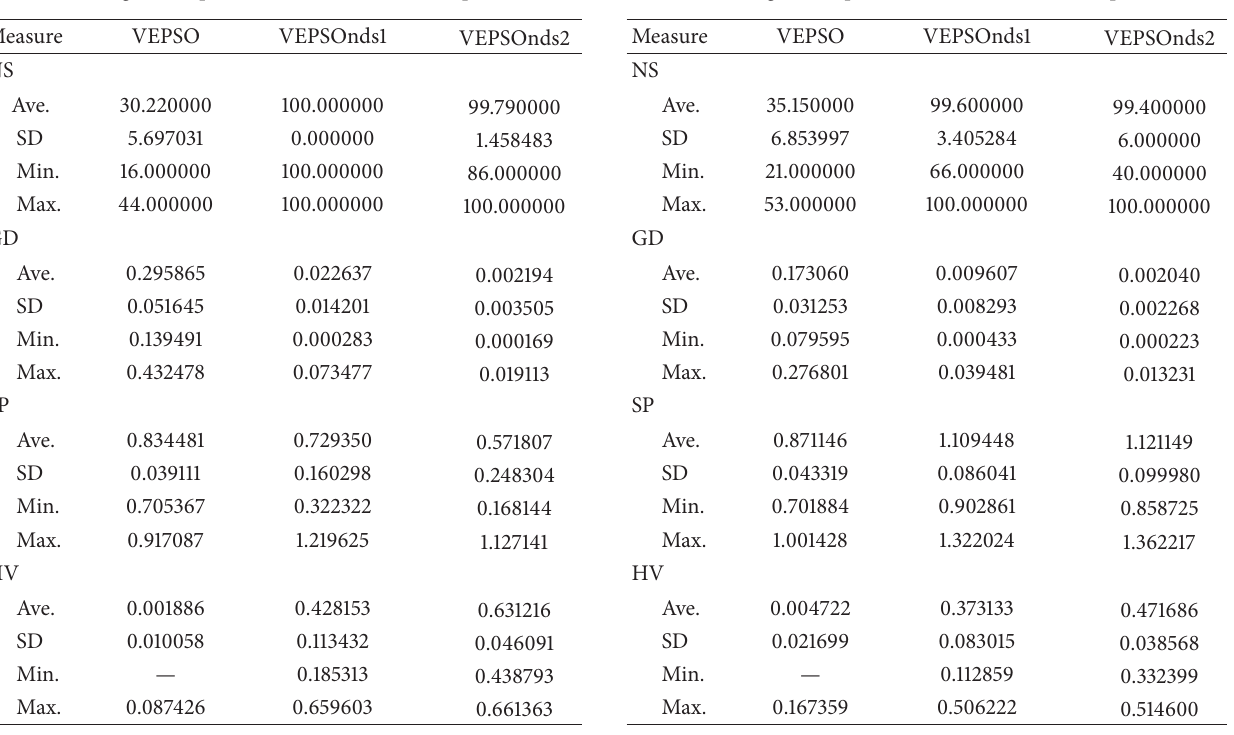
Table 1: Algorithm performance tested on ZDT1 problem.